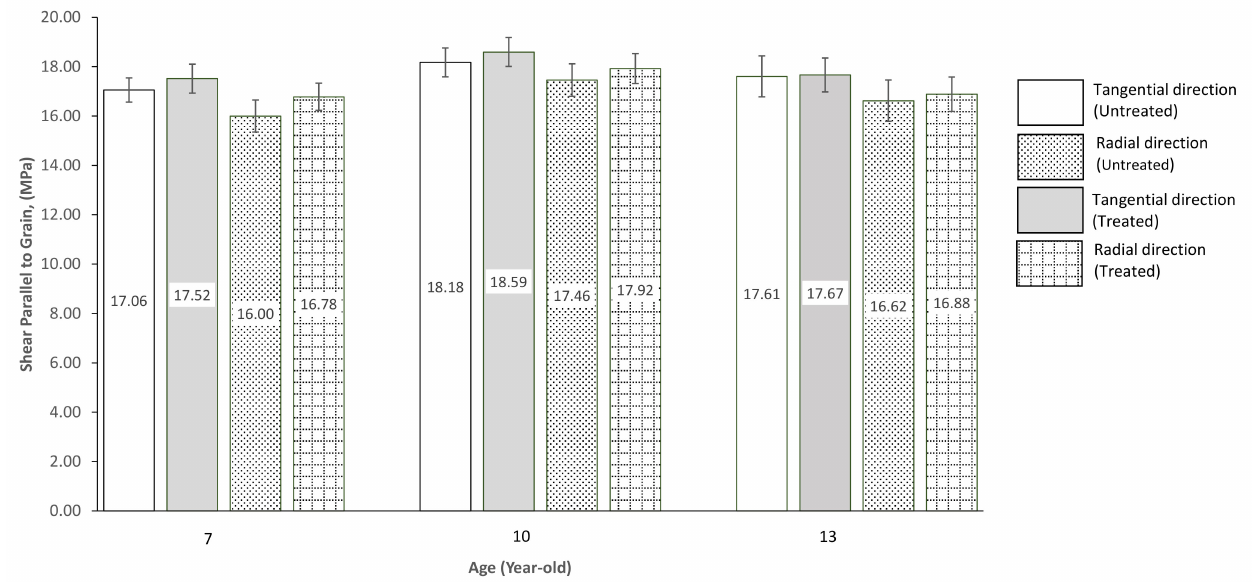
Figure 8. Shear parallel to grain mean values of Acacia hybrid sample comparing within the age groups, grain direction and treatment condition at air-dry